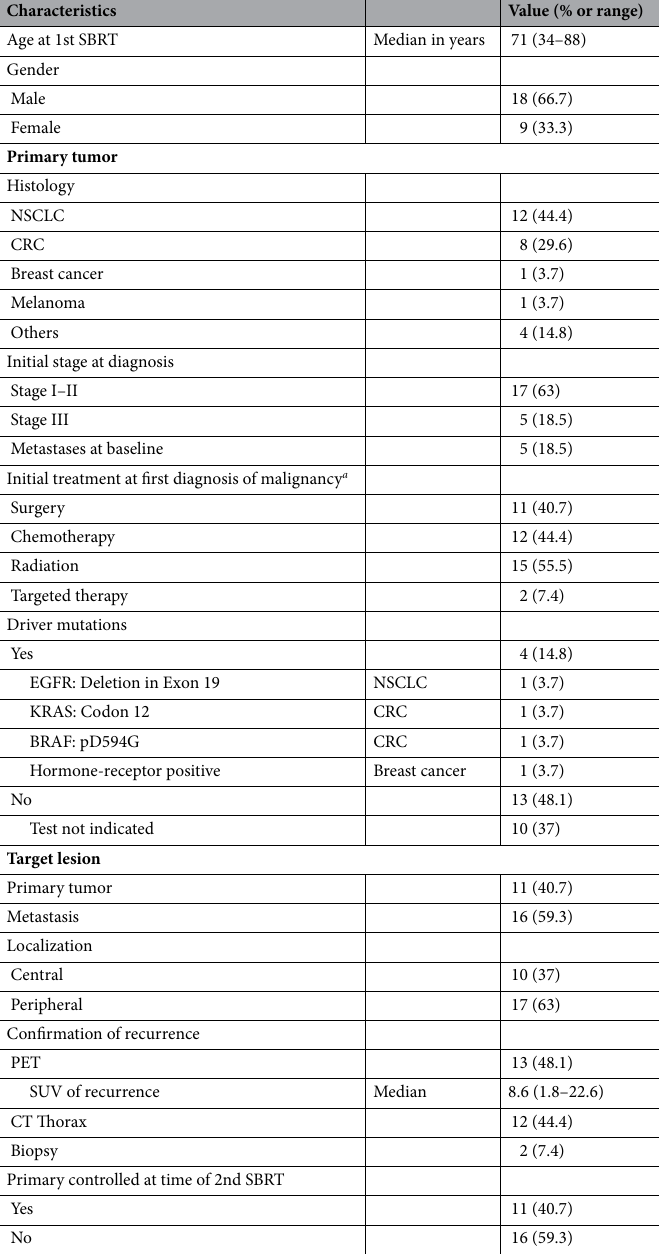
Table 1. Clinical and treatment-related characteristics, including initial treatment and stage at initial diagnosis. a Some patients had more than one initial treatment. SBRT, stereotactic body radiation therapy; NSCLC, non-small cell lung cancer; CRC, colorectal cancer; PET, positron emission tomography; SUV, standardized uptake value; CT, computed tomography; EGFR, epidermal growth factor receptor; KRAS, Kirsten rat sarcoma viral oncogene; BRAF, Serine/Threonine-Kinase